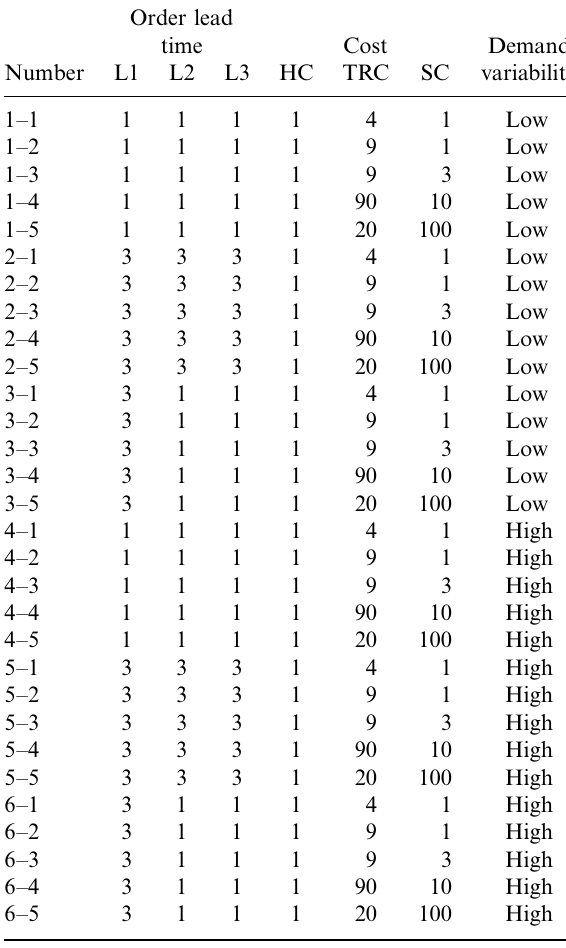
Table 1. Parameters for three manufacturers Order